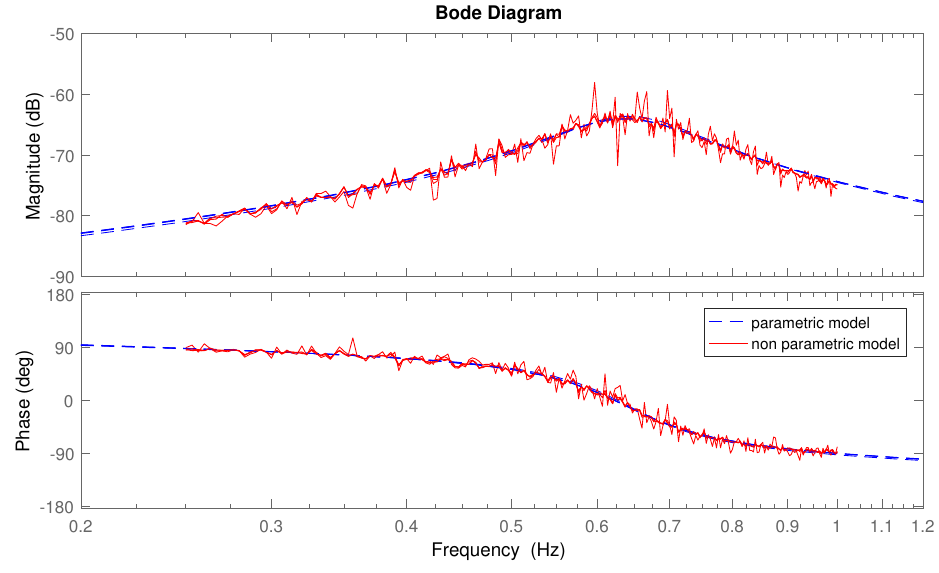
Figure 20. Bode plots and FRFs of the intrinsic admittance with zero friction Y 0 i